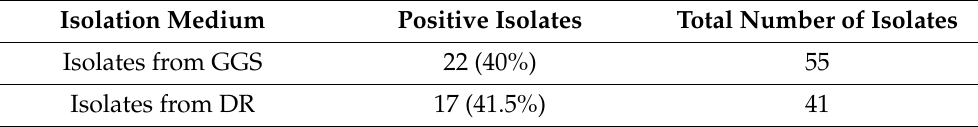
Table 3. Percentage of isolates capable of degrading lignin